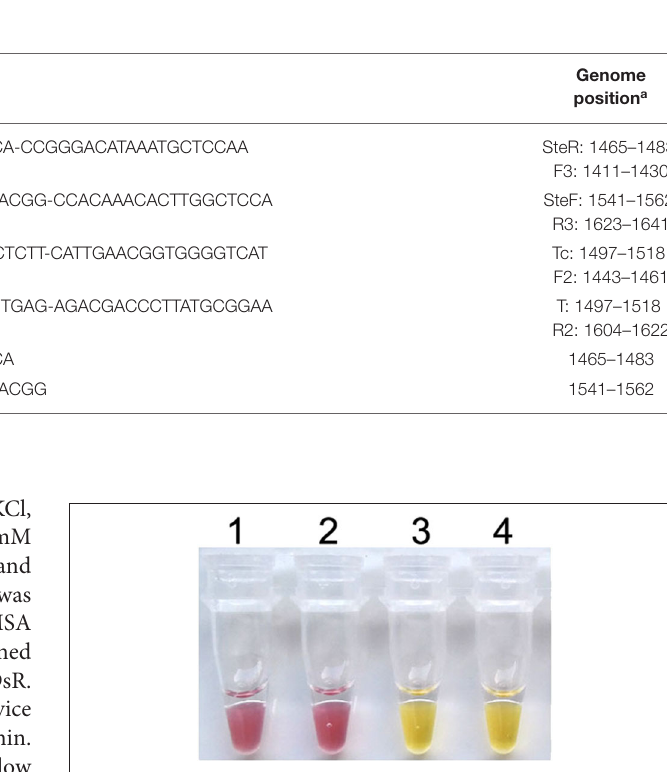
FIGURE 1 | Establishment of the colorimetric IMSA assay for PCV3. Tubes 1–2, negative control. Tubes 3–4, 10 5 copies of PMD19T-capsid plasmid